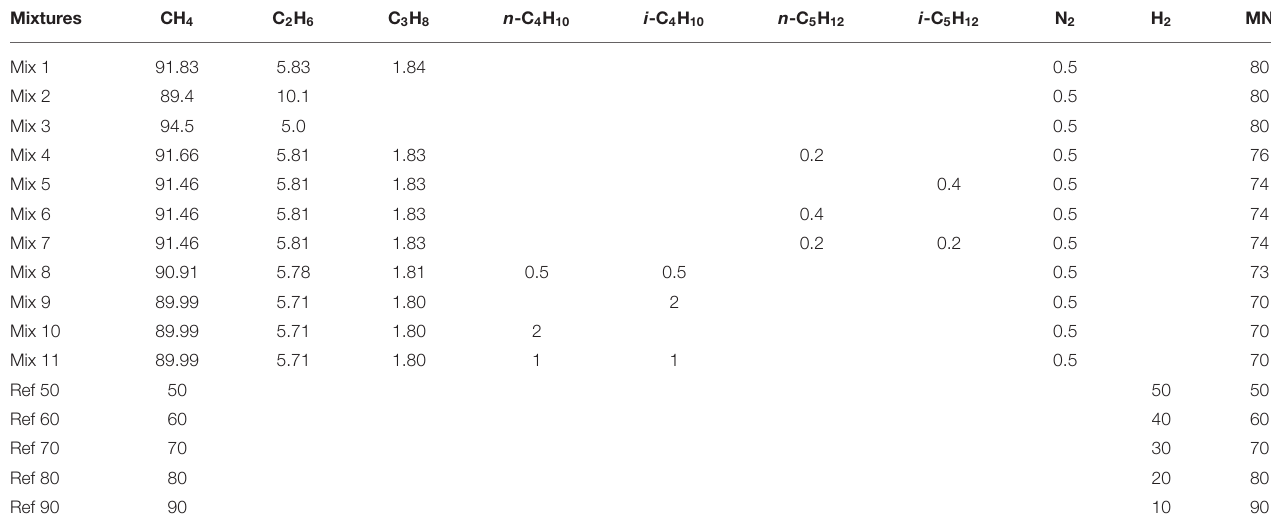
TABLE 1 | Compositions (% volume) of the tested liquefied natural gas (LNG)/liquefied biogas (LBG) mixtures and the reference mixtures in the high-pressure shock tube (HPST) as well as in the rapid compression machine (RCM).